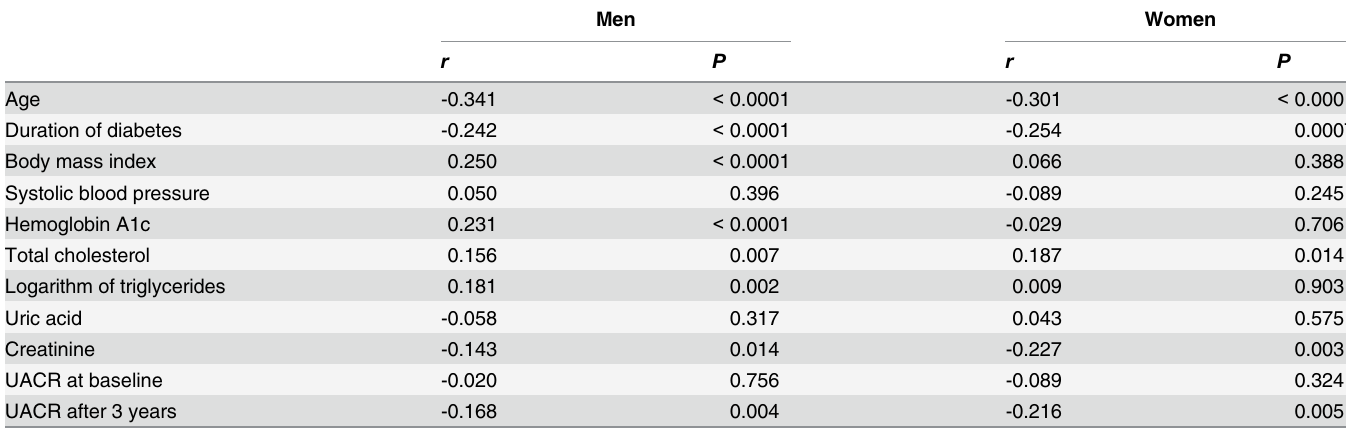
Table 2. Correlation between hemoglobin and other variables at